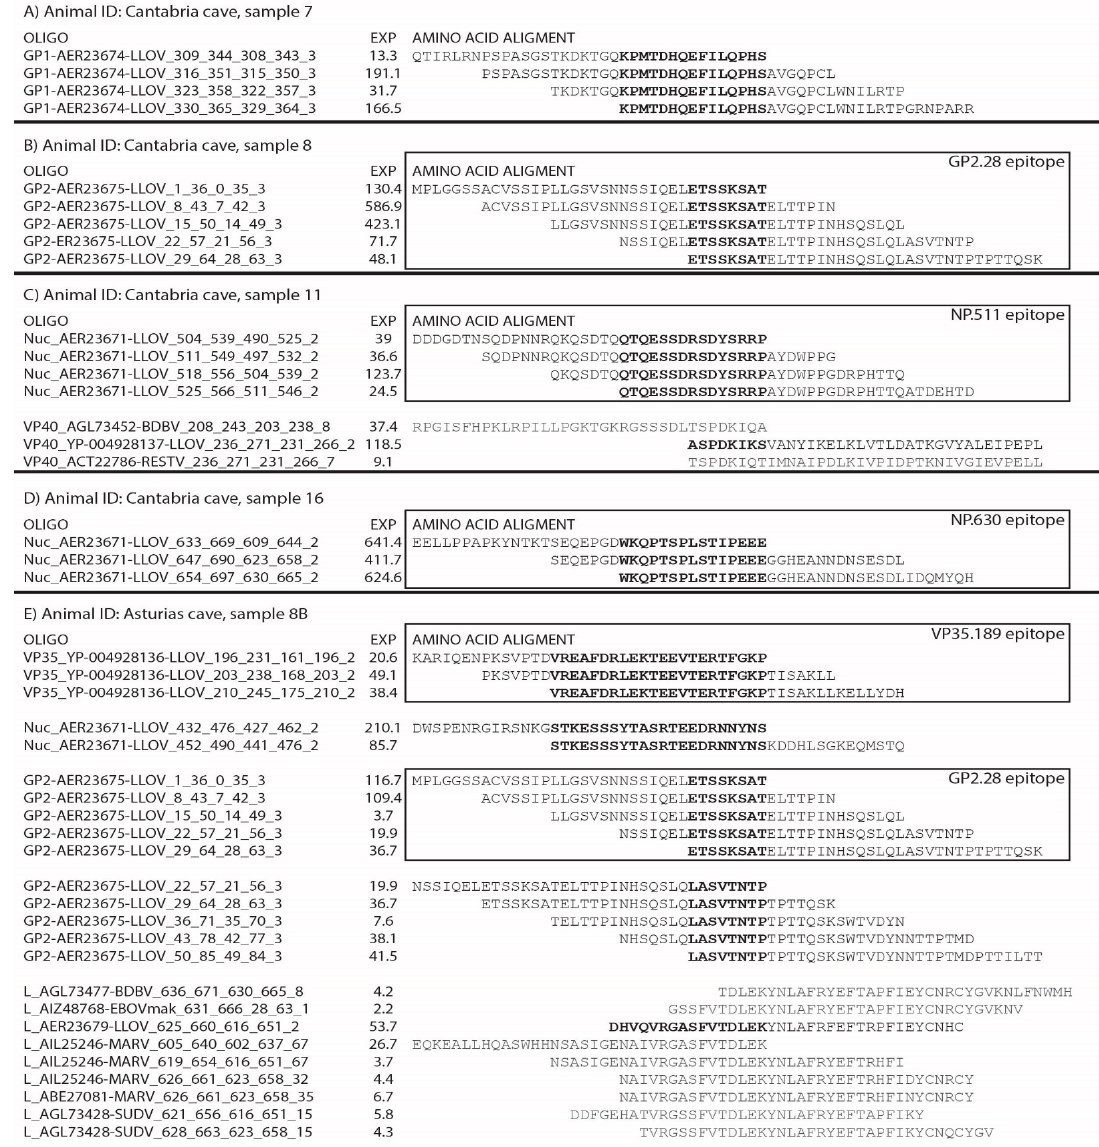
Figure 2. Representative examples of clusters of enrichment found in di ff erent Schreiber’s Bent-winged bats. In bold are the regions in common, within the cluster of enrichment (putative epitope). Some animals presented only one cluster, in GP 1 , GP 2 , or the nucleoprotein (NP); for animal (A, B, D) respectively. Other bats presented several clusters, in di ff erent proteins, NP and VP40, and viral protein-35 (VP35), NP, GP 2 and L; for animal (C) and (E), respectively. In the squares are represented immunodominant epitopes, GP2.28, NP511, NP 630 and VP35.189. Note: Due to the similarity on the L protein in this region within filoviruses, the last cluster of E) is a hybrid cluster, with phages encoding proteins from LLOV, BDBV, EBOV, MARV and SUDV. “Nuc” corresponds to the nucleocapsid protein (NP), “OLIGO” to the oligonucleotides forming the cluster of enrichment.